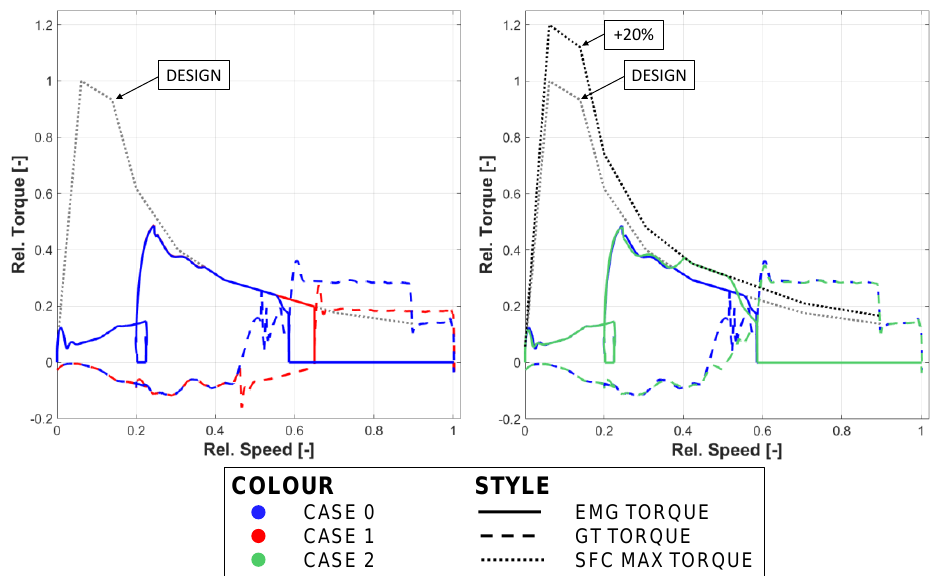
Figure 9. Start-up simulation up to Grid Synchronization. Normalised Static Frequency Converter (SFC) maximum torque curve, Electric Motor and Generator (EMG) and GT torques varying the normalised speed.